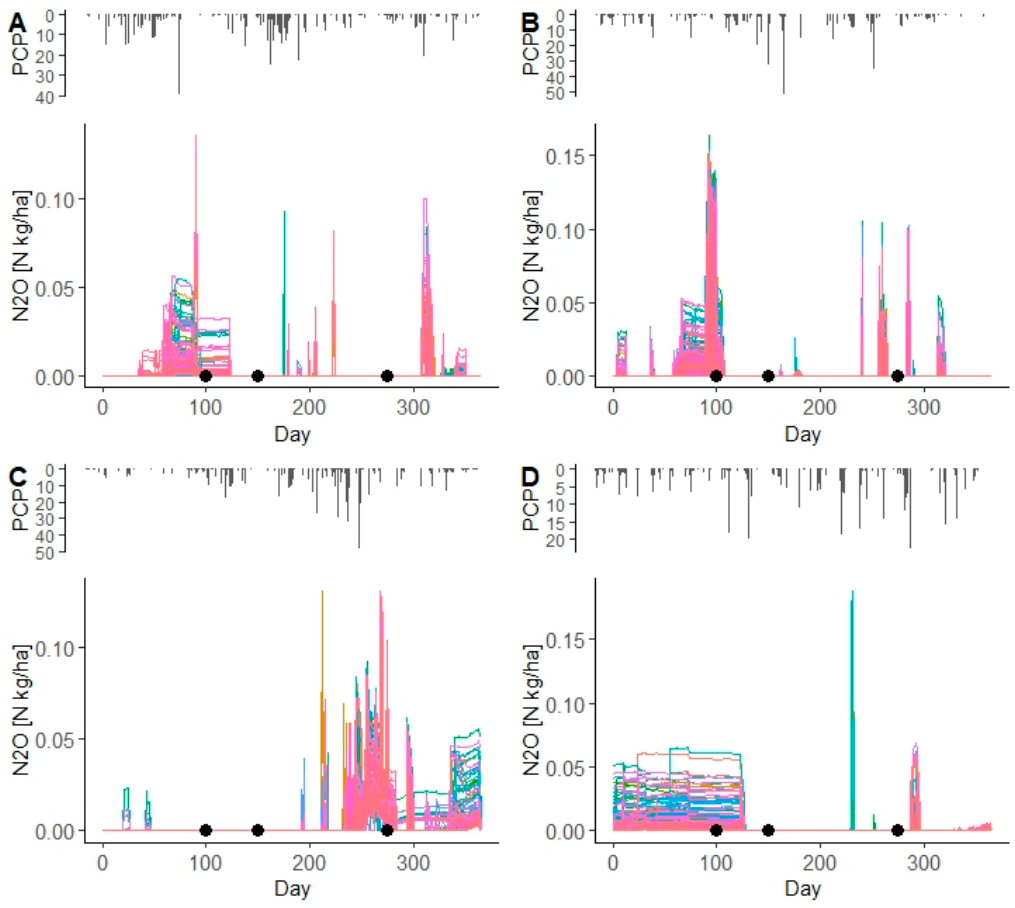
Figure 10. Simulated N 2 O emissions (color lines) from WWHT HRUs in the Zaya catchment for the years 2009 ( A ), 2013 ( B ), 2014 ( C ), and 2015 ( D ). PCP is daily precipitation (mm). Black points indicate the dates of N fertilizer application for the setup in the Zaya